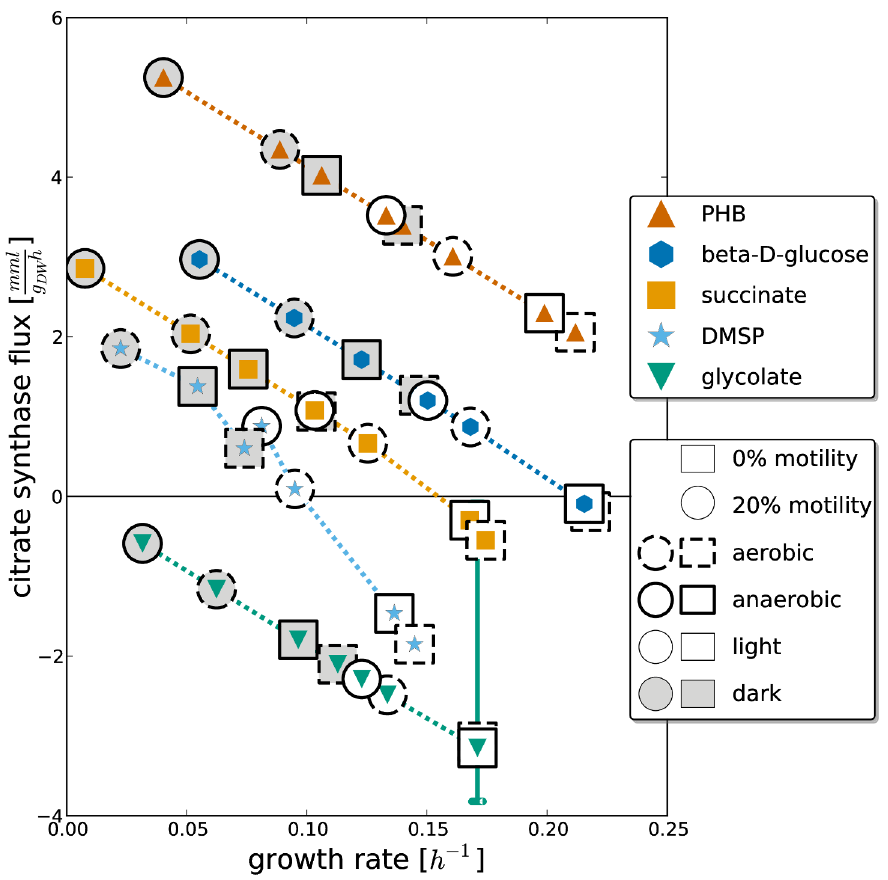
Figure 3. Overview of the wild type simulations. In this figure the growth rate is charted against the flux through the citrate synthase. The carbon source is given by the color and shape of the inner marker. Moreover, the outer marker indicates motility (shape), aerobic/anaerobic conditions (line style), and illumination (background color). No growth was predicted in any high motility physiological state for dark and anaerobic conditions if DMSP was used as carbon source. Hence, this entry is missing in the figure. PHB: polyhydroxybutyrate; DMSP: dimethylsulfoniopro- pionate.